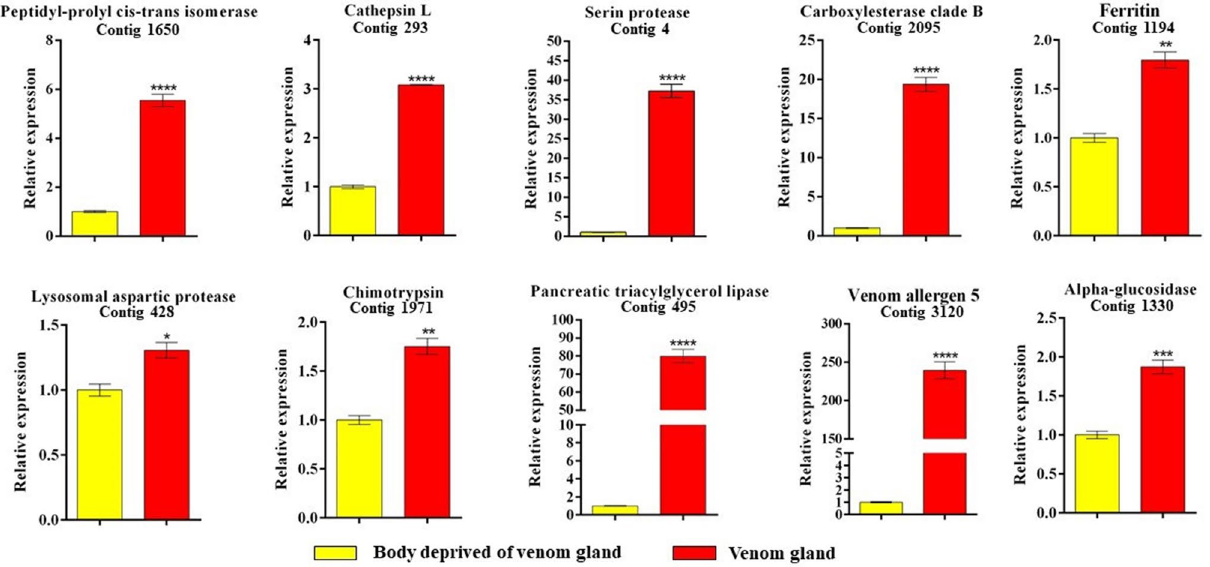
Figure 6. Relative expression level of ten selected genes of T. sinensis venom gland and T. sinensis female body deprived of venom gland. Gene expression levels were quantified by quantitative real time PCR (qPCR). Data represent the mean of three independent replicates ± SEM. Samples were compared by the Unpaired t-test and statistically significant differences between samples are indicated with asterisk (*p = 0.015, **p = 0.011, ***p = 0.0009, ****p < 0.0001). Reference genes: GAPDH and beta-tubulin. Calibrator sample: female body deprived of venom